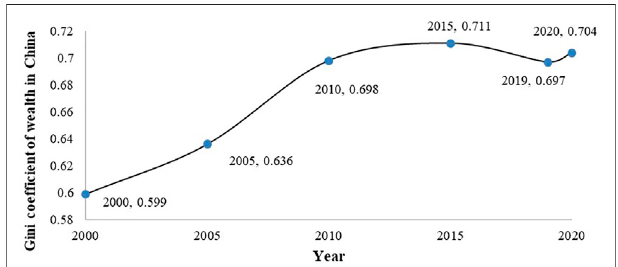
FIGURE 1 | Gini coef fi cient of wealth in China during